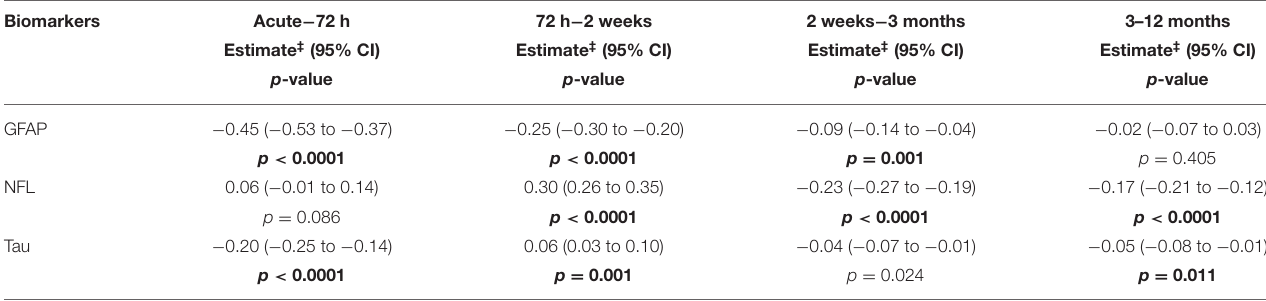
TABLE 3 | Differences in biomarker concentrations between time points in patients with mTBI, calculated using post-hoc contrast analyses based on the linear mixed model results.